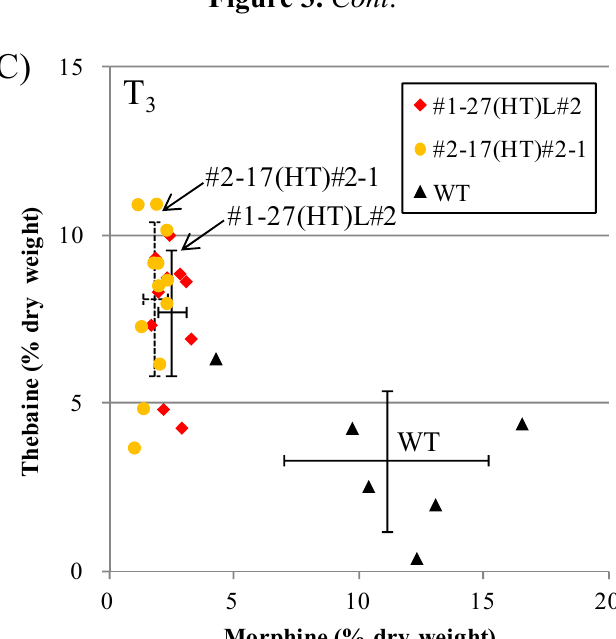
Crossed bars indicate the mean value (crossed point) and standard deviations for morphine (horizontal bar) and thebaine (vertical bar) contents in ( A ) PsM1-2 T ( B ) HT (#1-27 and #2-17 were combined) and LT (#2-1 and #2-6 were combined, dotted) lines, and ( C ) WT, #1-27(HT)L#2, and #2-17(HT)#2-1 (dotted) plant lines. ( A ) Lines #1-27(high thebaine, HT), #2-17(HT), #2-1(low thebaine, LT), and #2-6(LT) were used for analyses on T